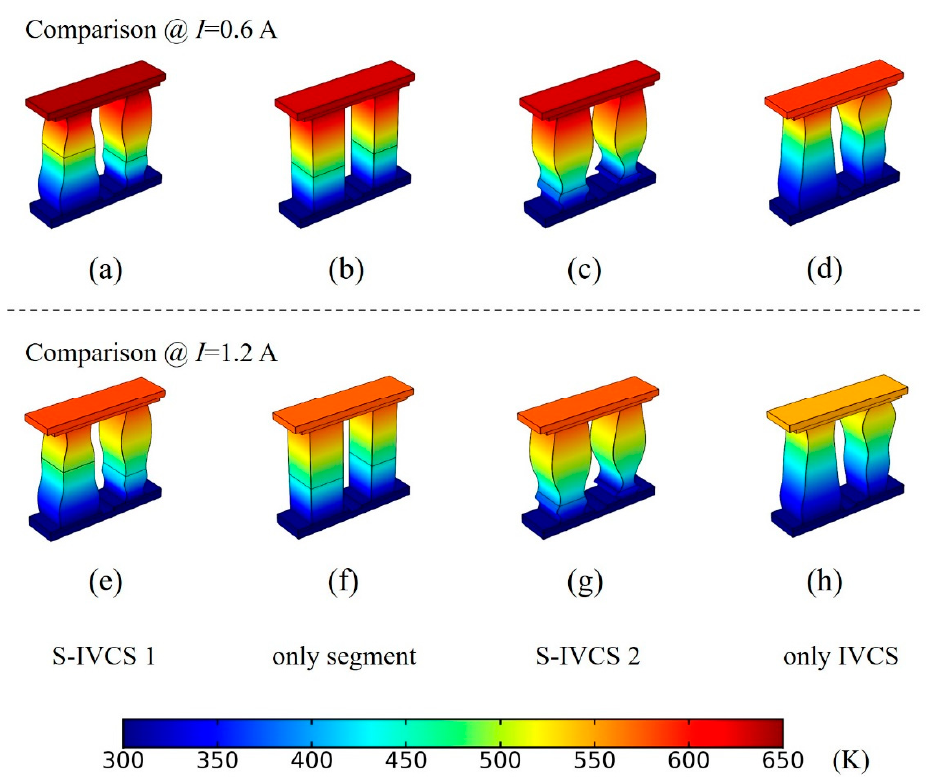
Figure 7. Temperature distribution of the four different designs at different current: ( a – d ) at current of 0.6 A; ( e – f ) at current of 1.2 A.